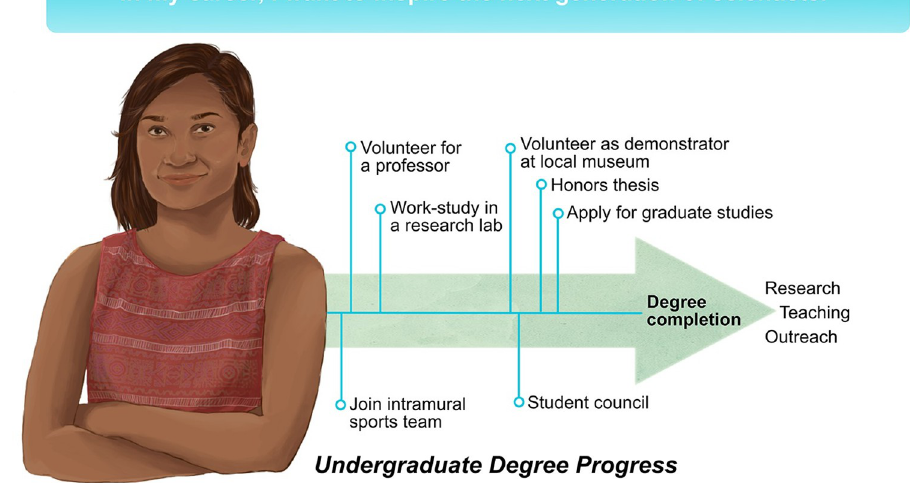
Fig 1. An example of a “vision,” which a student might start to develop as they enter their undergraduate STEM program. A vision statement need not be specific: This student, for example, knows that they want a career in which they can “inspire the next generation of scientists,” which can include research, teaching, and outreach. The plan details the important goals and milestones that will provide valuable experience in these domains and arranges these goals such that there is a variety of experiences, and that experiences can build upon one another. The goals are arranged in a relative timeline that tracks their undergraduate degree completion. The student’s plan also makes space for important social and leadership opportunities. As the student develops, they can refer back to their plan and alter it accordingly. S AU : AbbreviationlistshavebeencompiledforthoseusedthroughoutFig 1 andTable 1 : Pleaseverifythatallentriesarecorrect : TEM, Science, Technology, Engineering, and Mathematics.